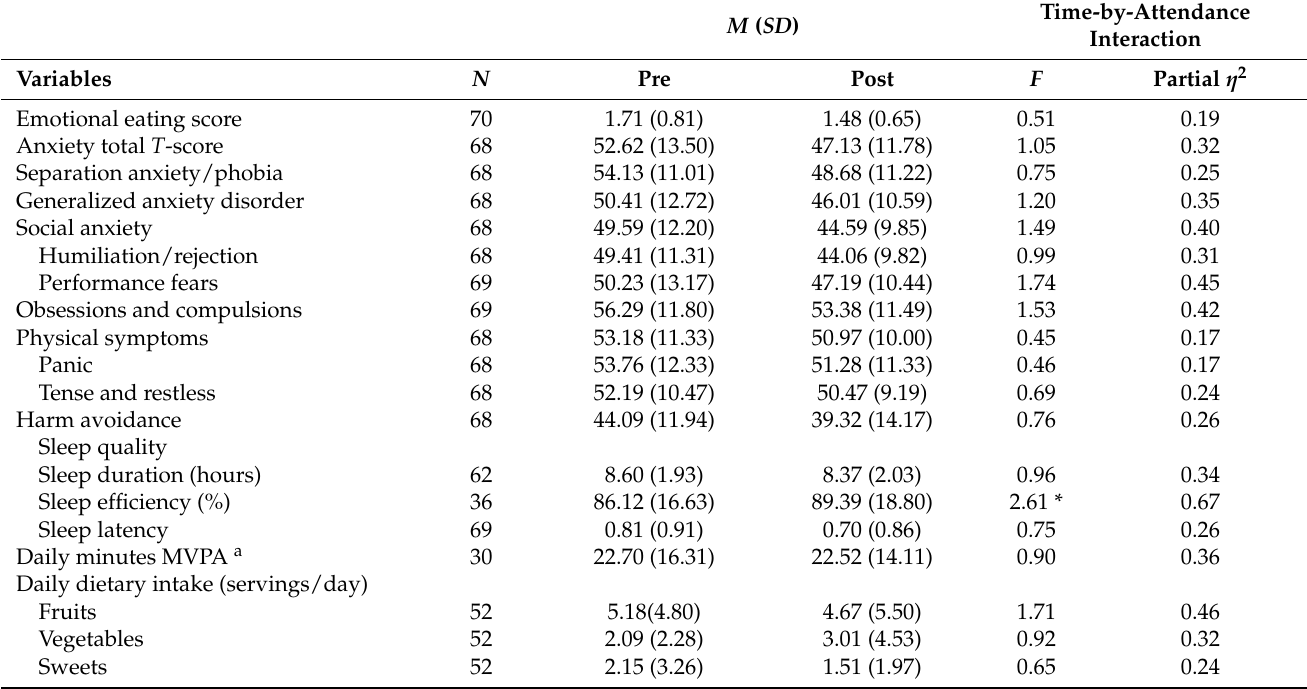
Table 4. Pre- and post-intervention changes in outcome variables in the experimental group as a function of